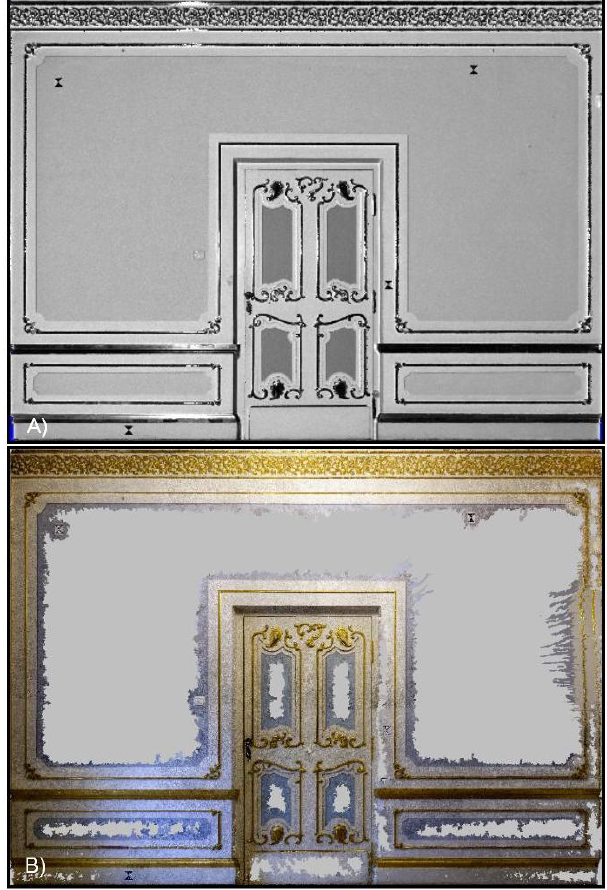
Figure 4. A) Orthoimage from reflectance intensity. B) Orthoimage generated based on the point cloud from image